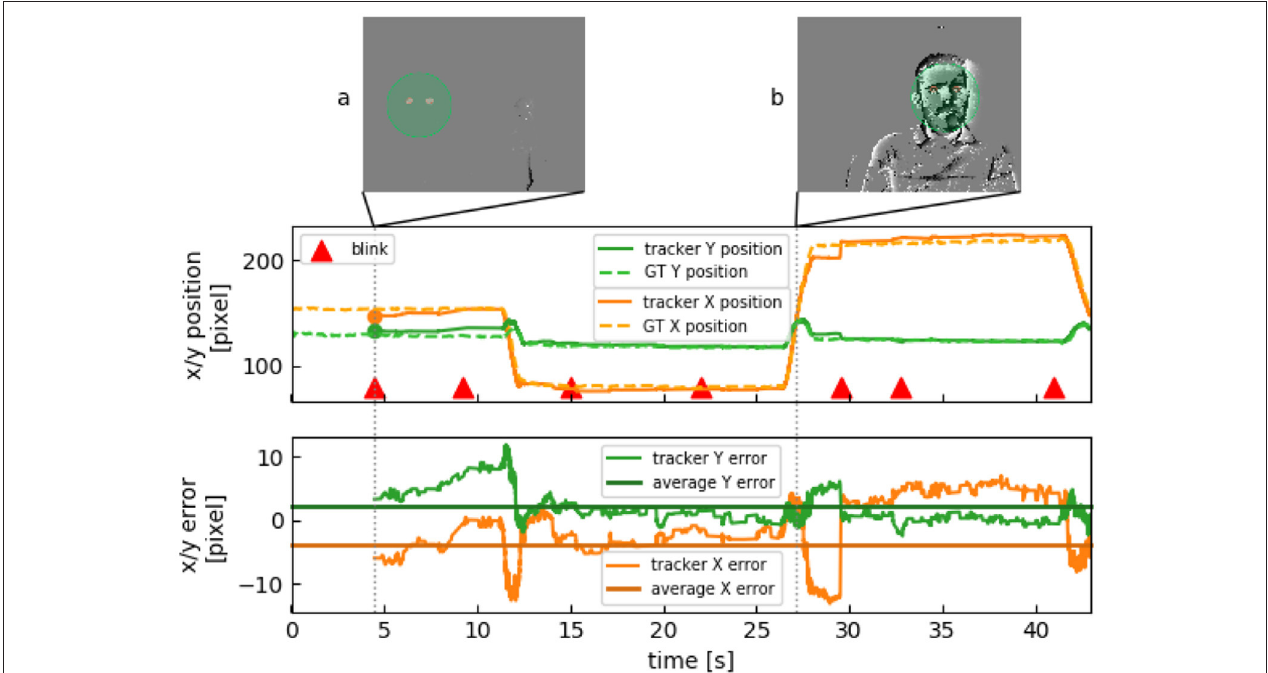
FIGURE 5 | Face tracking of one subject over 45 s. (A) Subject stays still and eyes are being detected. Movement in the background to the right does not disrupt detection. (B) When the subject moves, several events are generated.